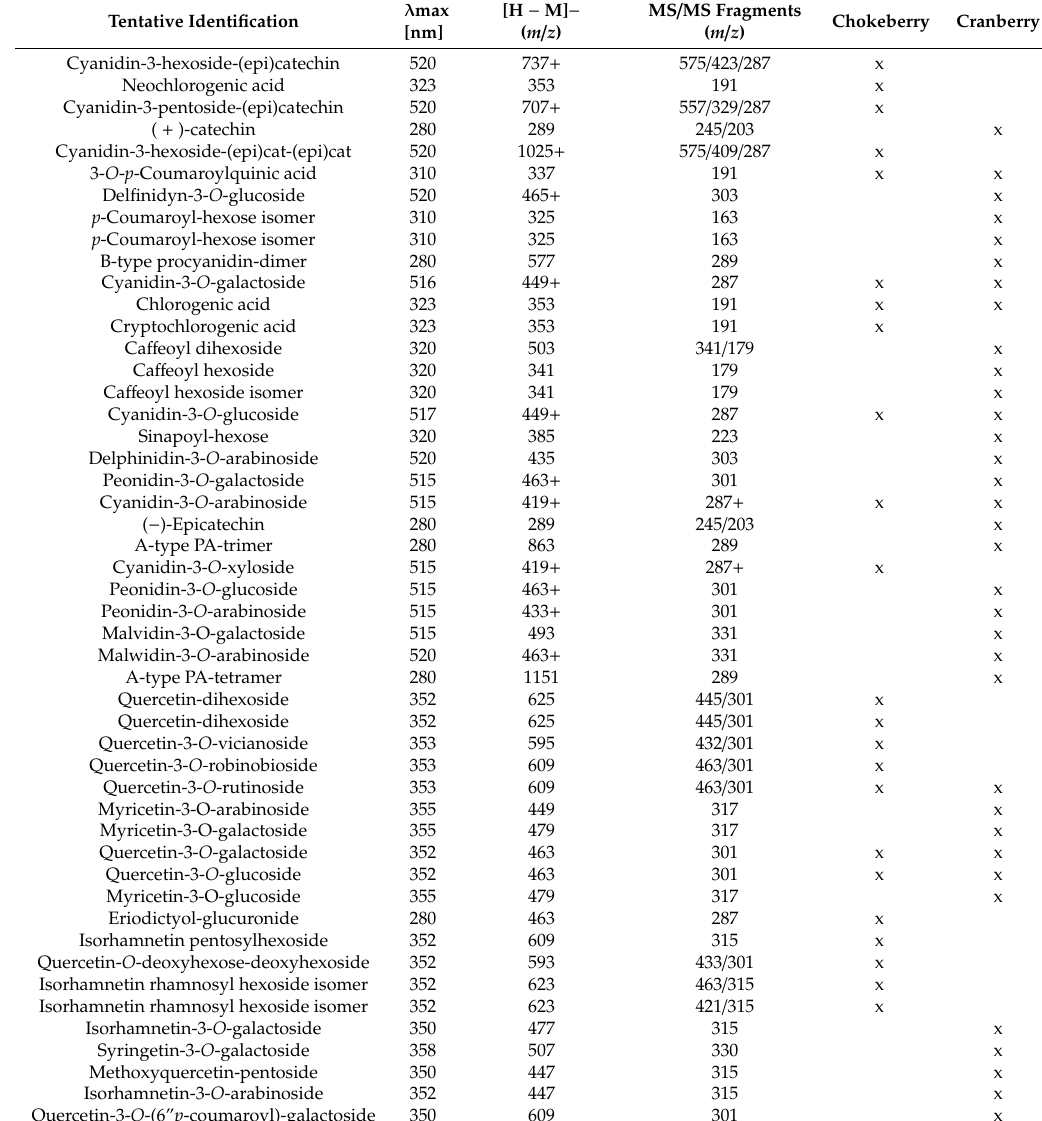
Table 4. Identification of polyphenolic